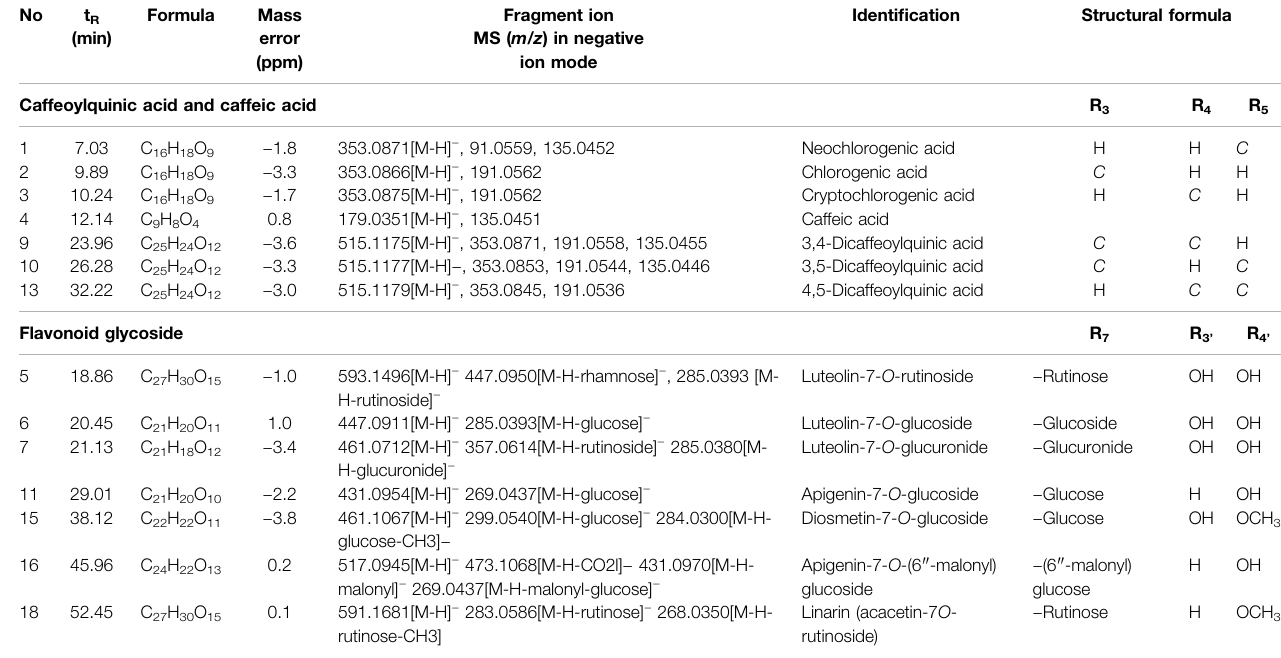
TABLE 2 | Characterization of constituents by LC-MSn analysis in negative-ion